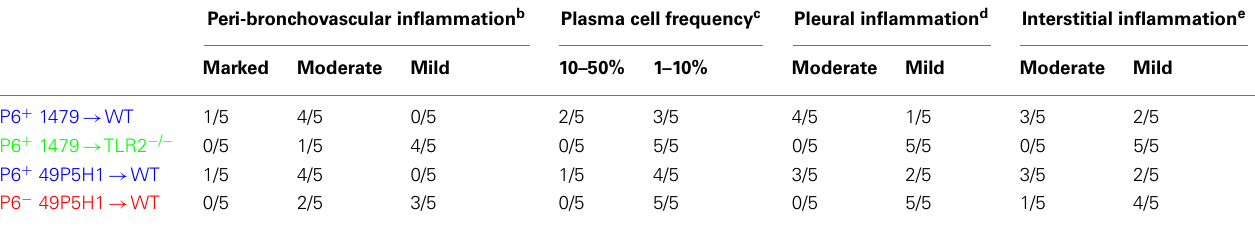
Table 1 | Pathological evaluation of lung inflammation a .